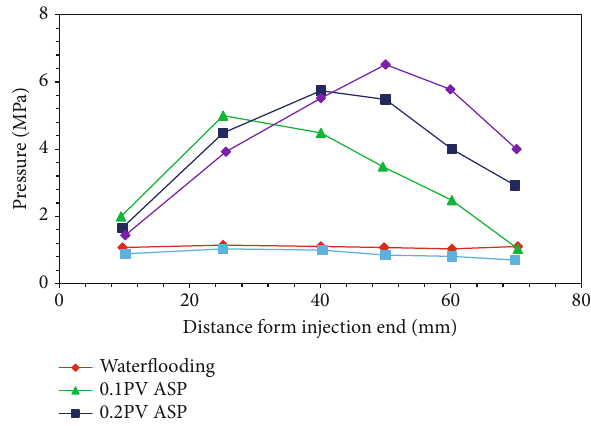
Figure 16: Pressure variation curve of ASP fl ooding process.